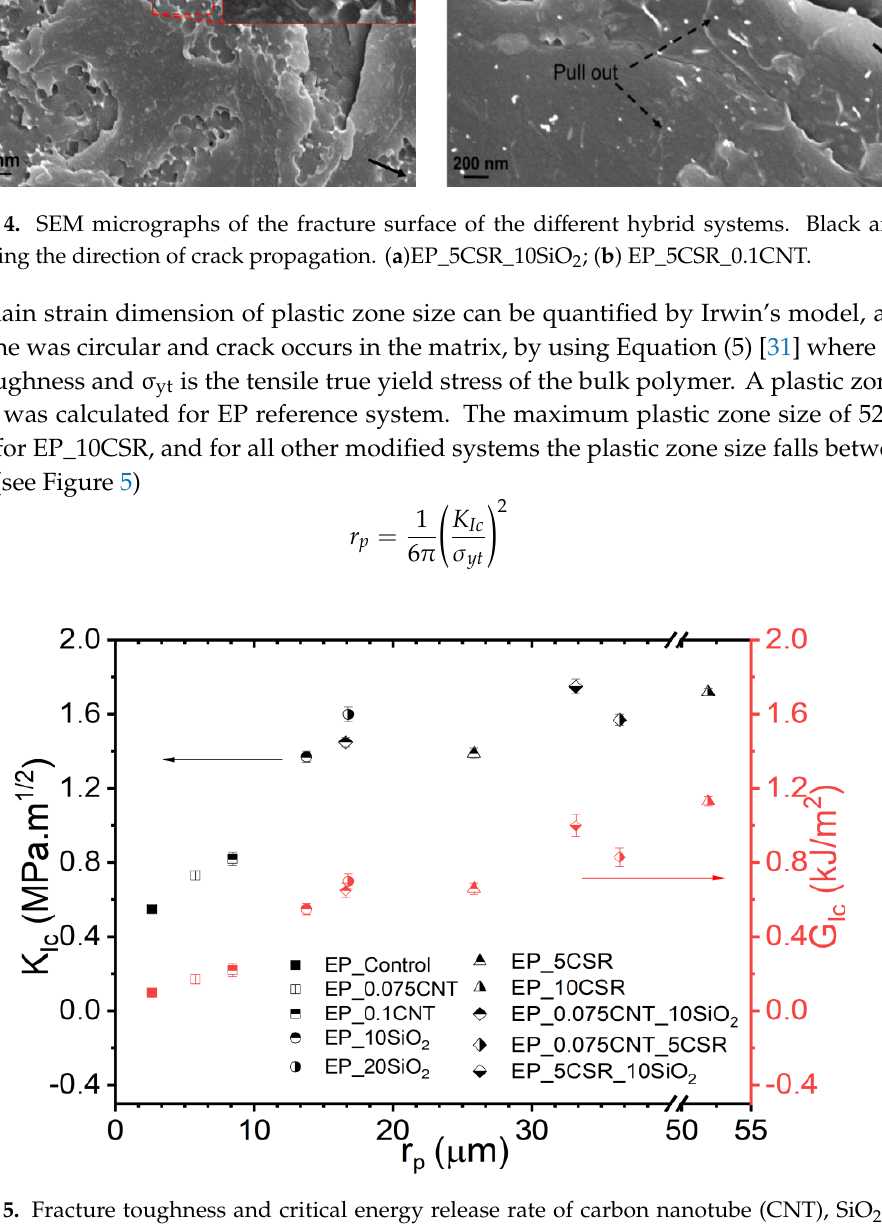
Figure 6. Normalized graph showing the relation between the normalized fracture toughness and normalized modulus of elasticity for different modified epoxy/amine systems in comparison to reference epoxy system. Electrically conductive systems are also mentioned in the figure. It can be observed from the normalized graph (Figure 6) that, for CNT modified systems modulus and fracture toughness increases with increase in CNT concentration but the increase in values is very marginal. For SiO 2 modified systems maximum increase of 3 and 1.2 times was observed for fracture toughness and tensile modulus respectively for EP_20SiO 2 system. Similarly, for CSR modified systems an increase of 3.25 times was noted for EP_10CSR system. Hybrid systems, containing CNT have electrical conductivity ~ 0.0022 S/m with additional increase in fracture toughness values. Normalized map represents different properties for various nanocomposites making it convenient to select a typical system for certain property requirement.